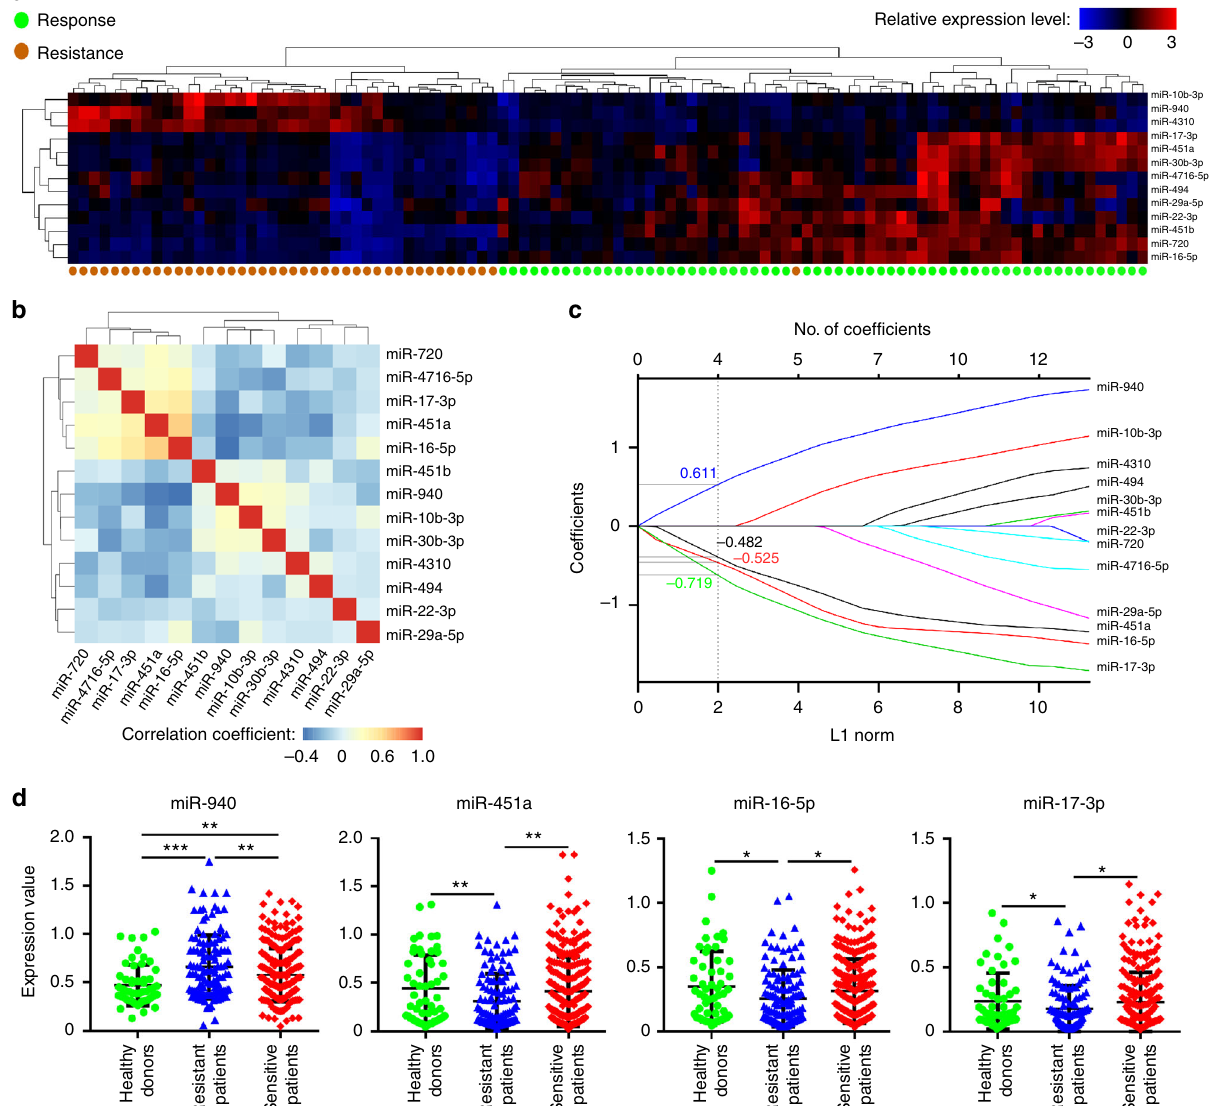
Fig. 1 Construction of a four miRNA-based signature. a Hierarchical clustering of 13 serum miRNAs expression level in HER2 + MBC. Hierarchical clustering of serum samples from 61 patients responding to treatments (in green) and 42 patients resistant to treatments (in brown) with the 13